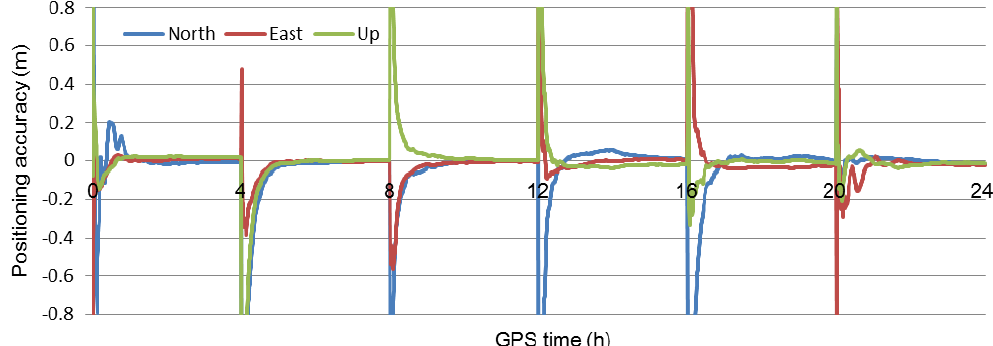
Figure 6. Positioning results of the user CMCJ for the six 4-h sessions. Table 2. Positioning accuracy and convergence time.